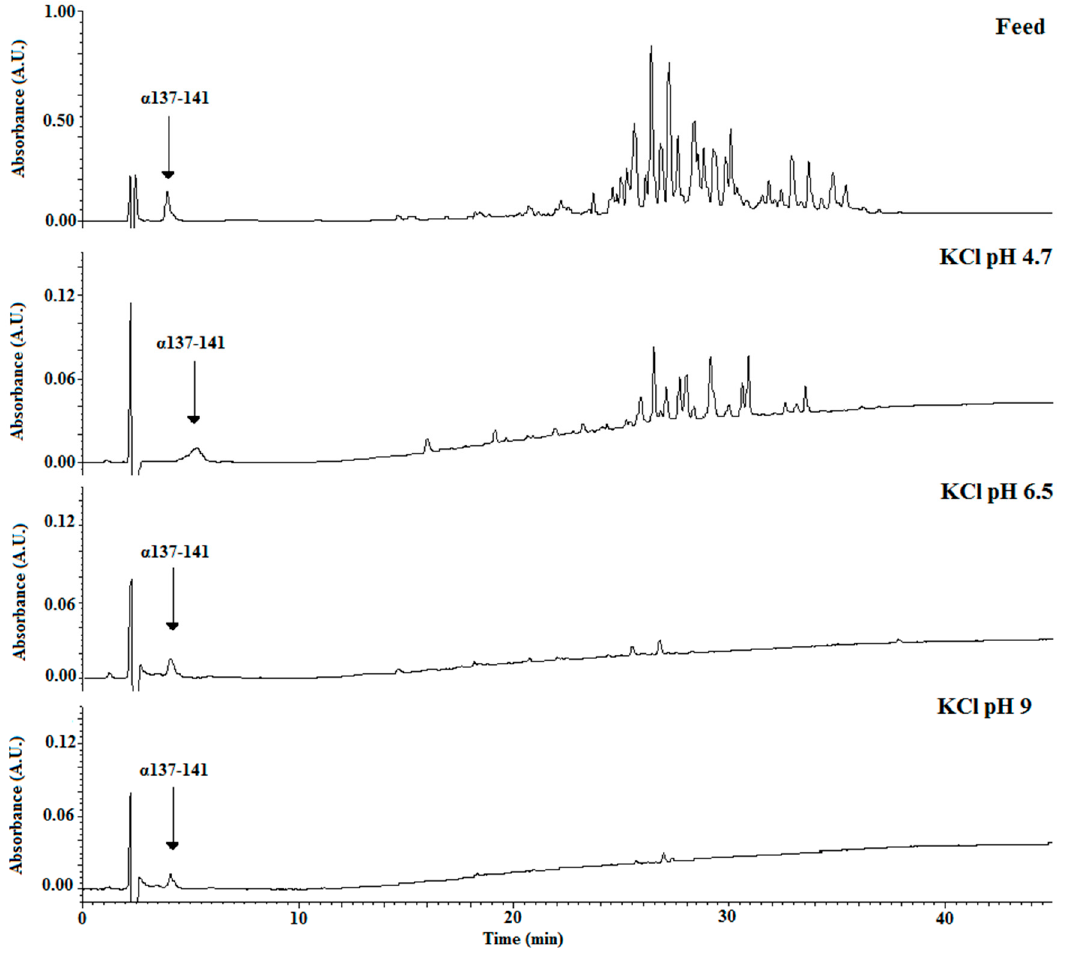
Figure 6. Chromatographic profiles of recovered total peptides after 2 h of EDUF treatment on the basis of the pH control value (4.7, 6.5, and 9).